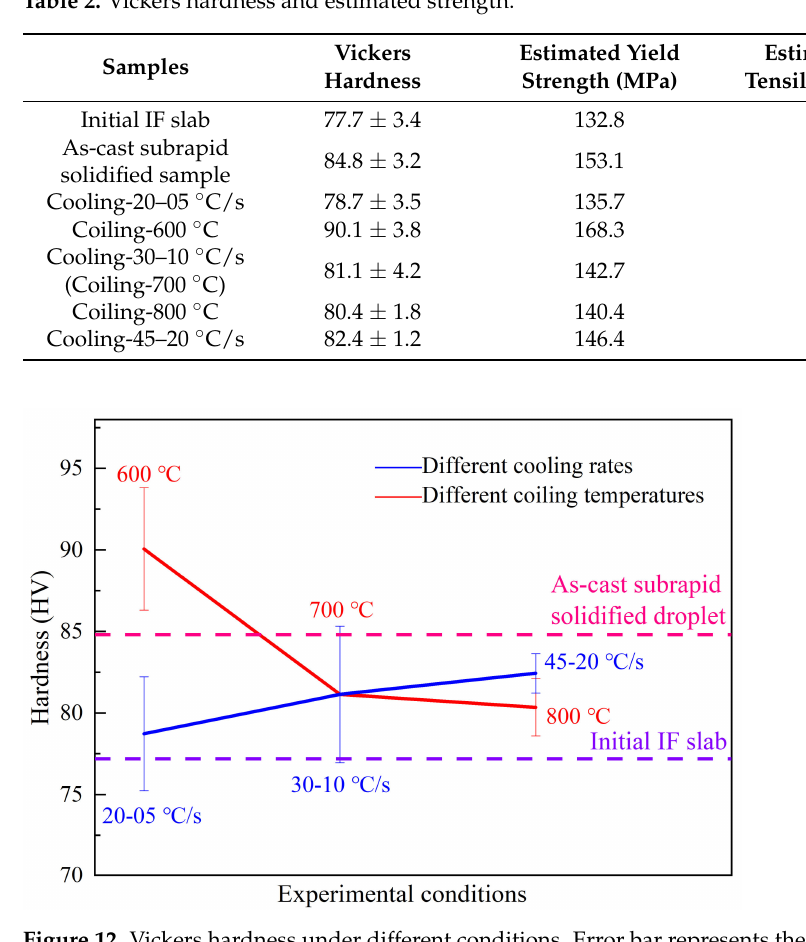
Figure 12. Vickers hardness under different conditions. Error bar represents the standard